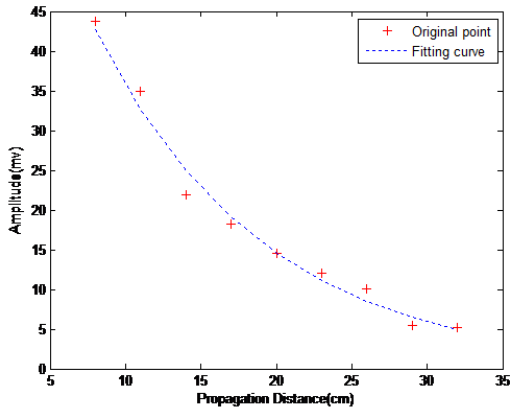
Figure 7: Fitting curve for the specimen